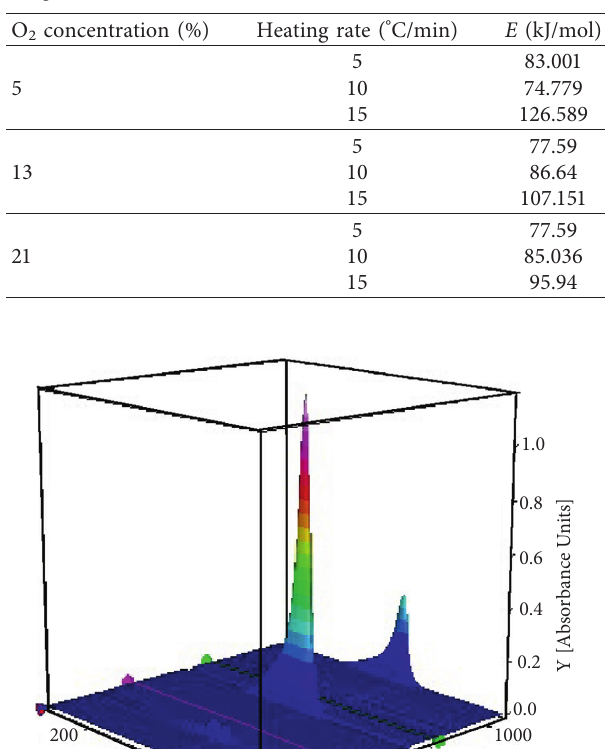
Table 3: Values of activation energy for the Bulianta 12# raw coal sample as obtained from kinetic modelling under different oper- ating conditions.